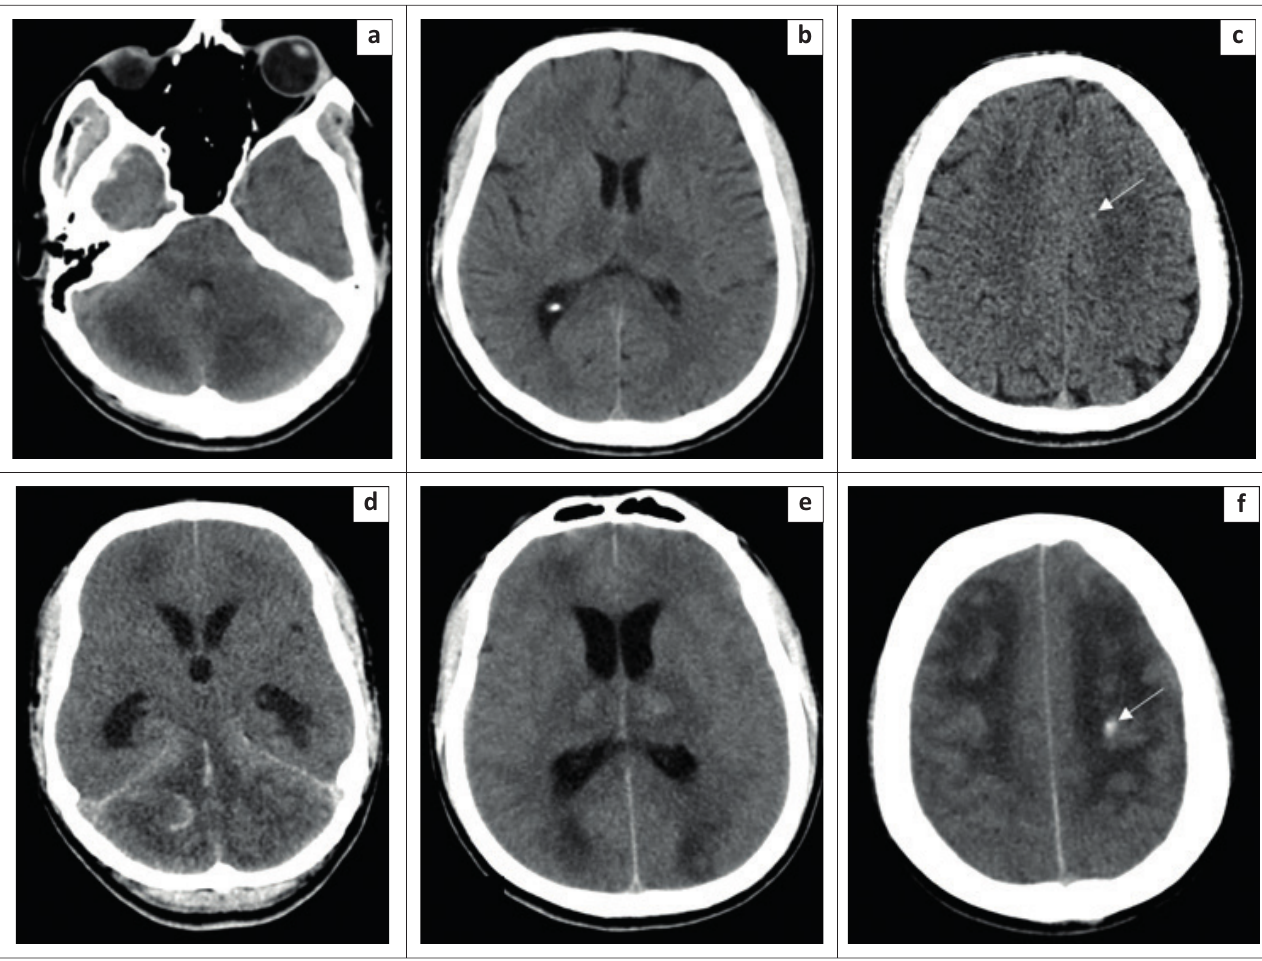
FIGURE 1: [Case 1]: Axial CT section in a 25-year-old male demonstrating ill-defined symmetric hypodense areas involving the bilateral thalami, cerebellar white matter and bilateral frontal subcortical and deep white matter (a–c). Tiny hyperdense foci were seen within some of these regions (white arrow). A repeat CT study performed a day later revealed an increase in the hypodensities and the haemorrhagic foci with intraventricular extension of the haemorrhage and resultant obstructive hydrocephalus